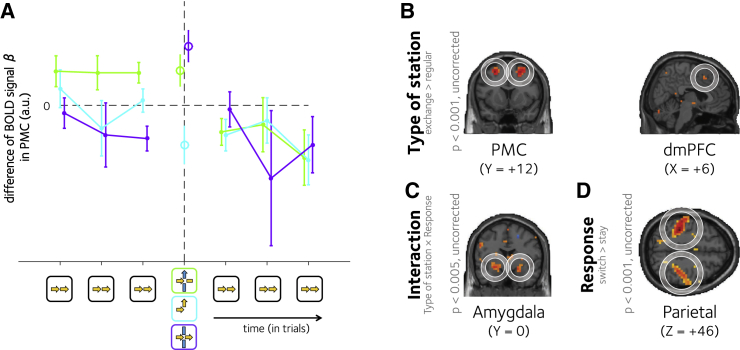
BOLD Responses to Bottleneck States(A) BOLD signal β values (mean ± SEM) from single-trial GLM approach in the PMC on three regular stations preceding (leftmost points) and following (rightmost points) a context switch (green lines), an exchange station without line change (purple lines), or an elbow station (cyan lines). The activation at the context switch, exchange station, or elbow are shown with a single point in the corresponding color. The averaged BOLD signal β in regular stations is represented by the horizontal dashed line.(B) Voxels responding to the main effect of station type (exchange > regular) in the PMC (left) and dmPFC (right).(C) Voxels in the amygdala responding to the interaction between station type and response.(D) Voxels in the parietal cortex responding to the main effect of response switch. The coordinates in MNI space are provided under each slice. The significant regions within a circle survived multiple comparisons correction.